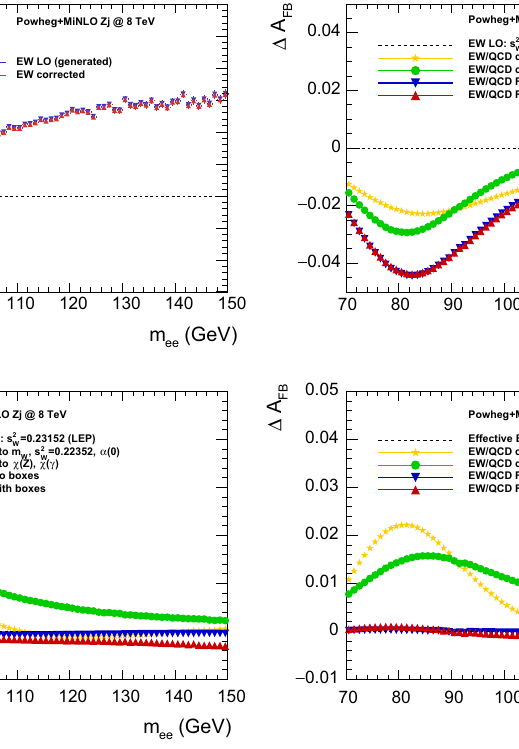
are shown in consecutive plots, where as a reference (black dashed line) respectively: (i) EW LO α( 0 ) scheme (top-right), (ii) effective Born (LEP) (bottom-left) and, (iii) effective Born (LEP with improved norm.) (bottom-right), was used